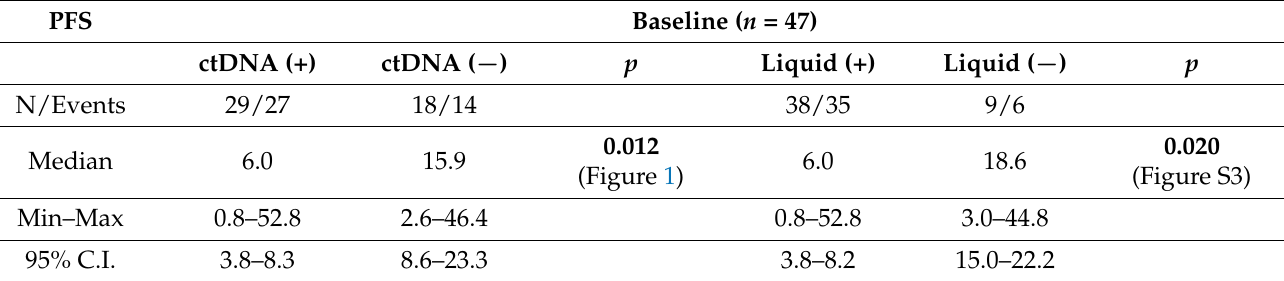
Figure 2. OS for Patients with detectable and non-detectable ctDNA at baseline ( A ), Post-1 ( B ) and, at the EOT ( C ). Table 4. PFS and OS based on ctDNA and LB